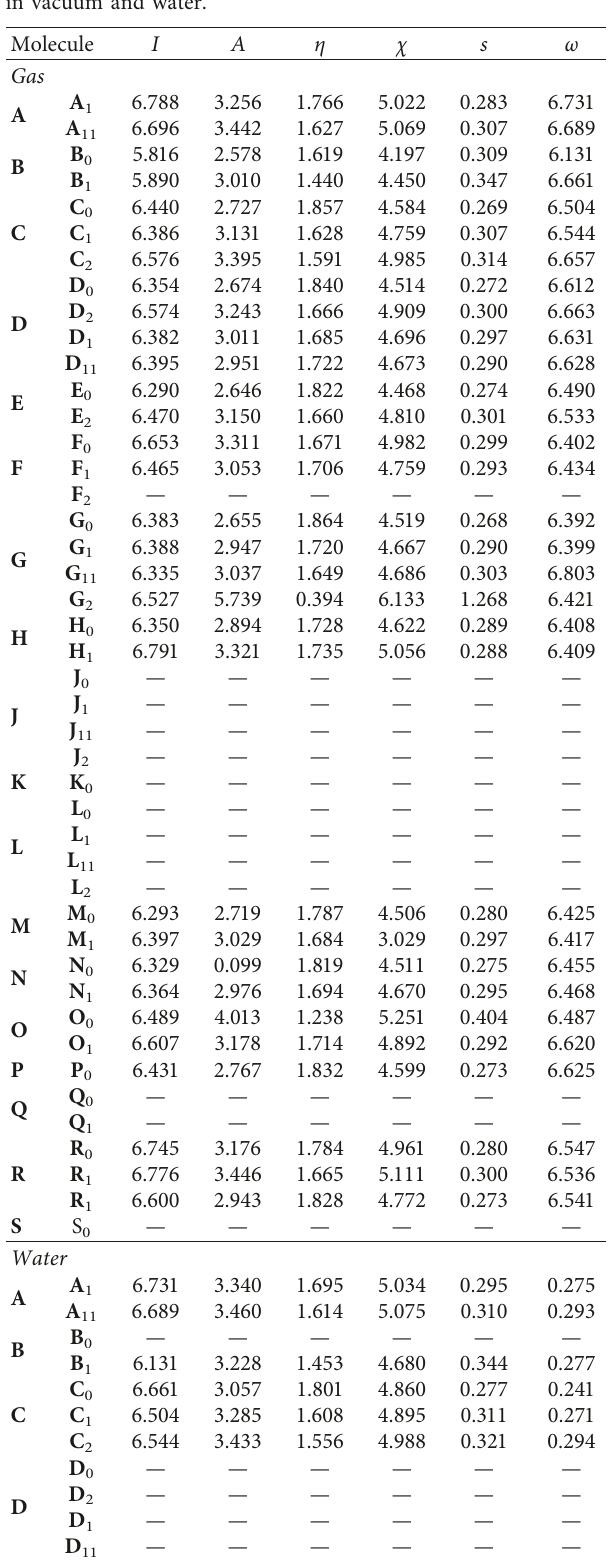
Table 4: Ionization potential (IP in eV), electron affinity (A in eV), global hardness ( η in eV), global softness (S in eV), and electro- philicity index ( ω in eV) calculated at B3LYP/6-311++G(d,p) level in vacuum and